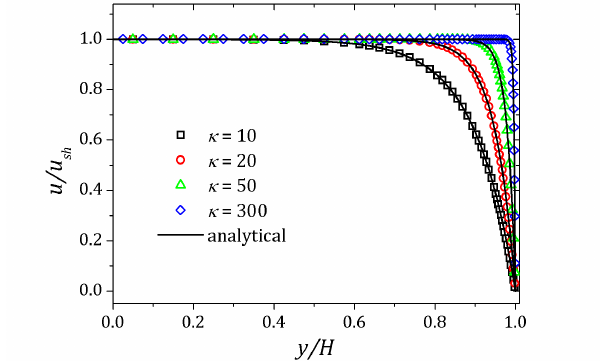
Figure 4. Velocity profile for Newtonian fluid flow. Results for κ = 10,20,50,300.